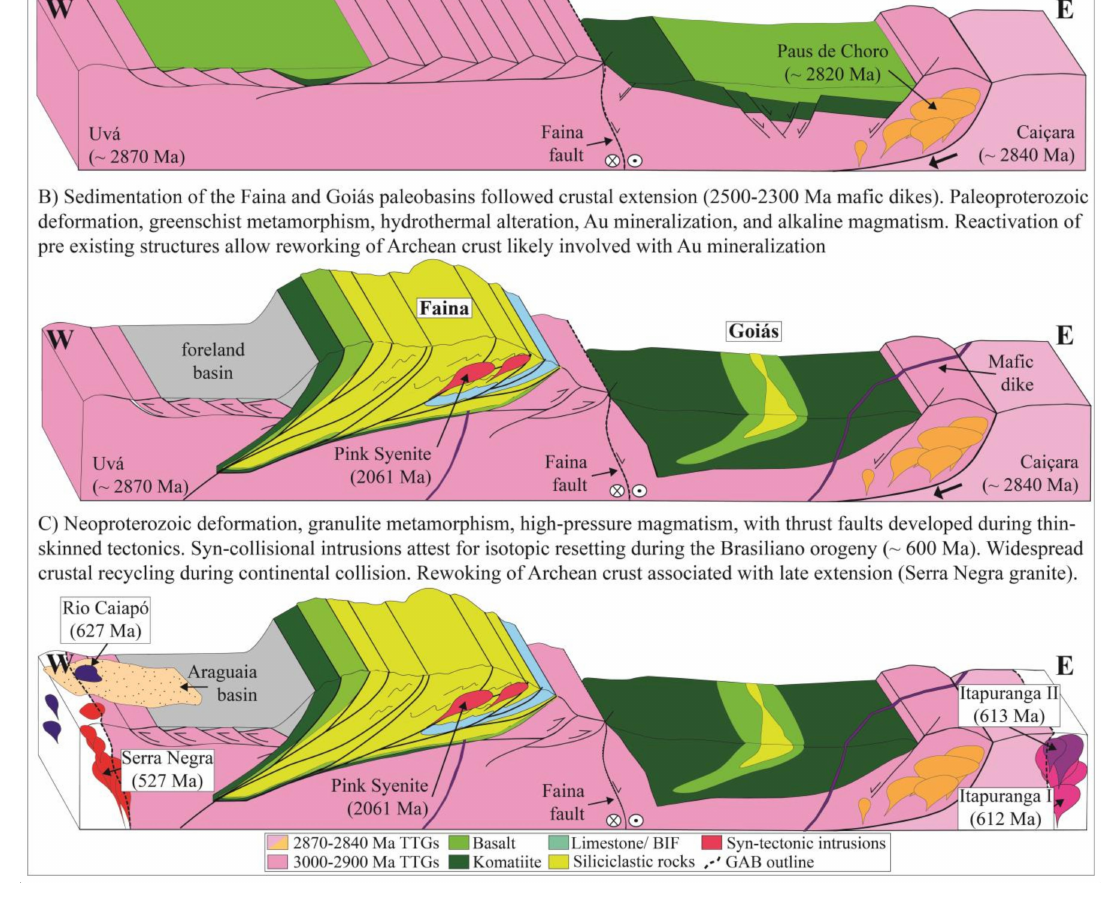
Figure 8. Schematic block diagrams showing the evolution of southern GAB during ( A ) Archean event, ( B ) Paleoproterozoic event, and ( C ) Neoproterozoic event (not to